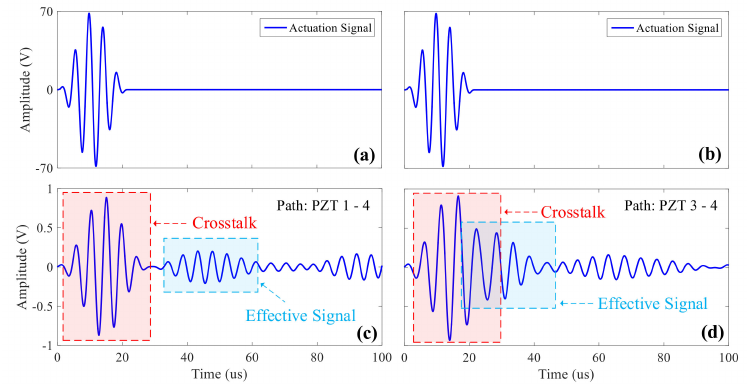
Figure 2. Acquisition diagram of a conventional ultrasonic guided wave system: ( a , b ) 190khz actuation signal; ( c ) e ff ective isolation between crosstalk and e ff ective signal; ( d ) overlap between crosstalk and e ff ective